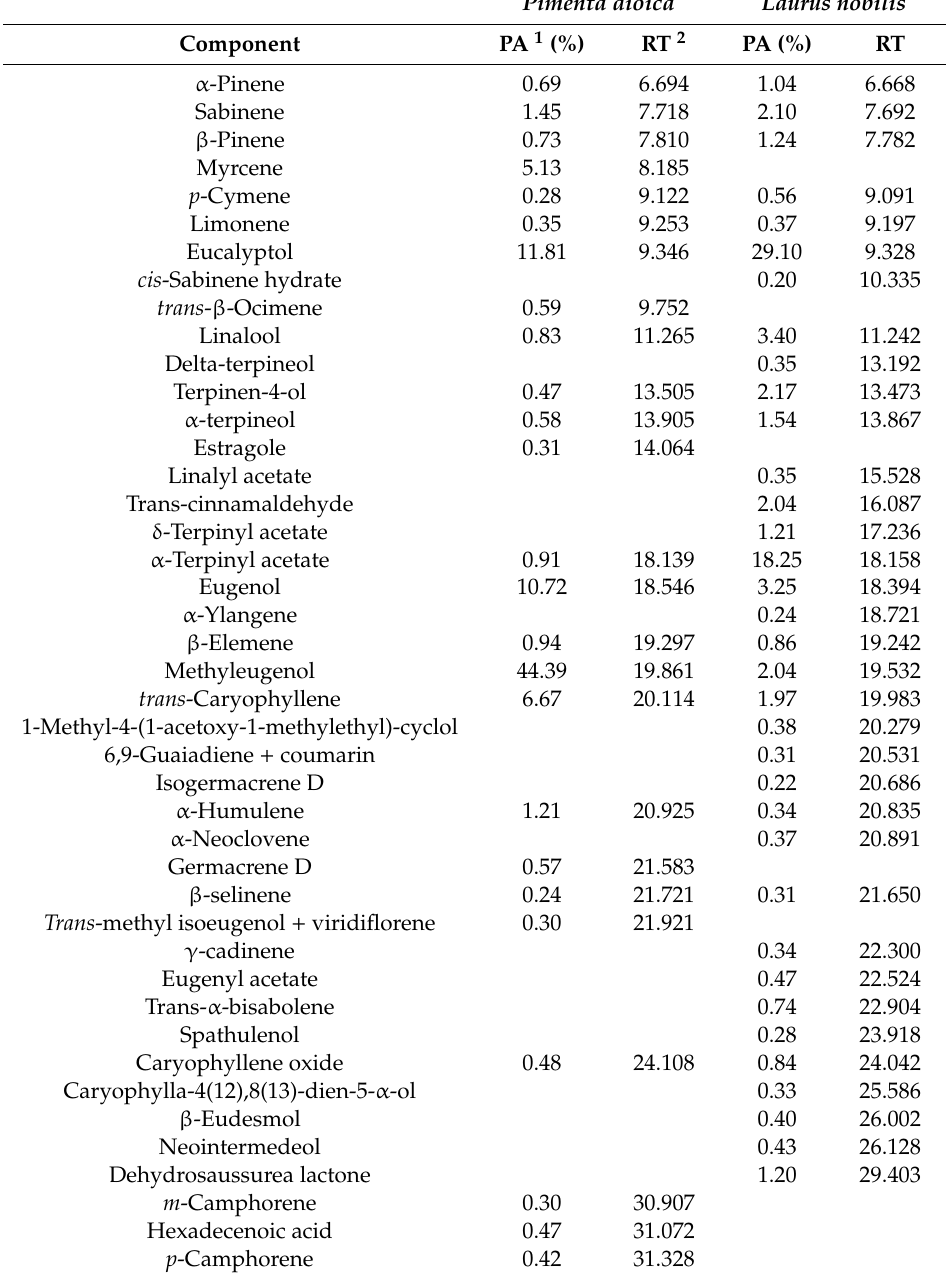
Table 3. Volatile components of pimento ( P. dioica ) and laurel ( L. nobilis ) extracts. Results are presented as means ( n =